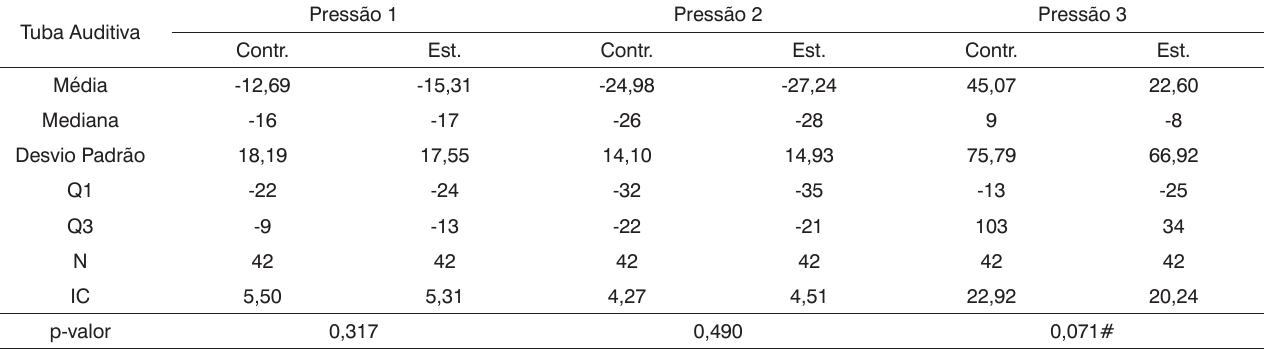
Tabela 5. Valores descritivos da variação da pressão da tuba auditiva dos grupos controle e